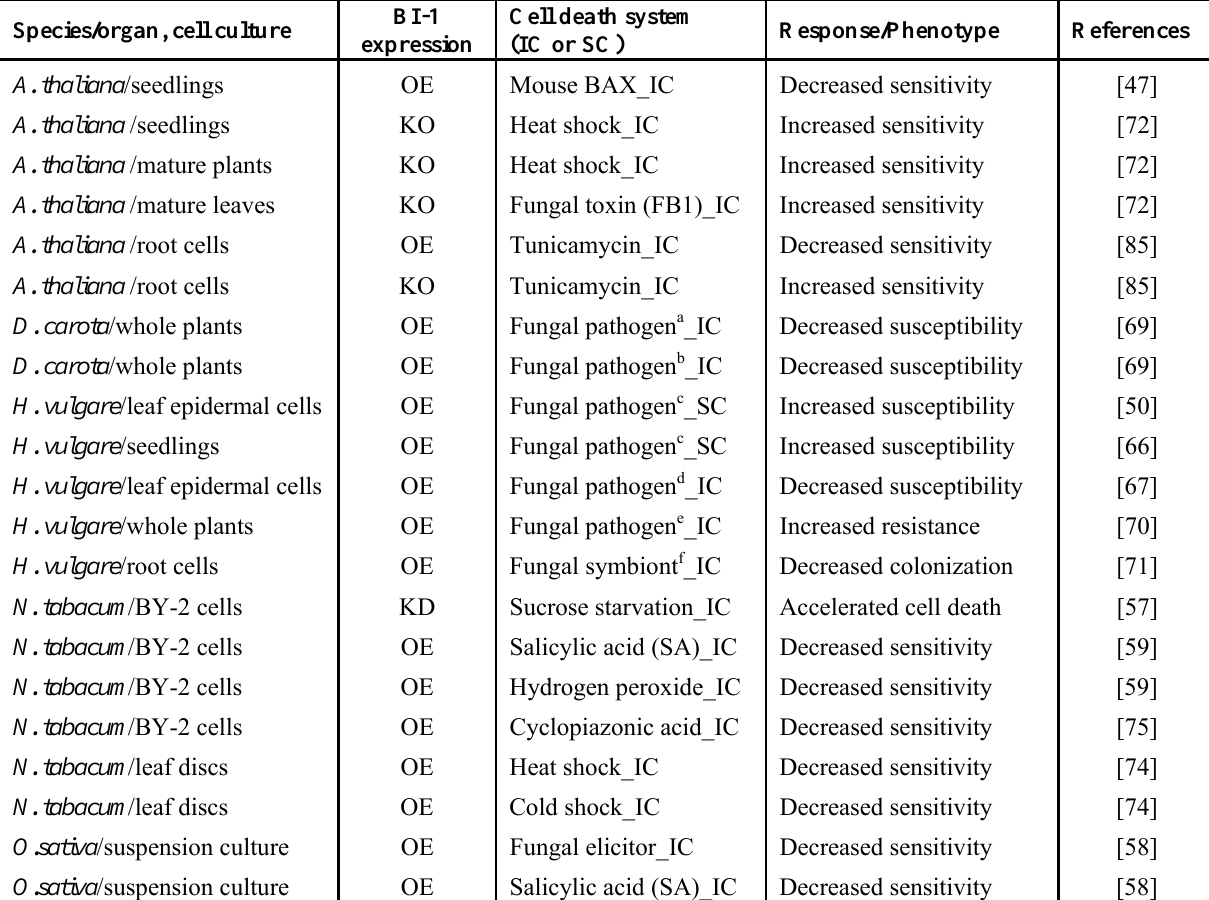
Table 1. Stress-induced cell death controlled by BI-1 in